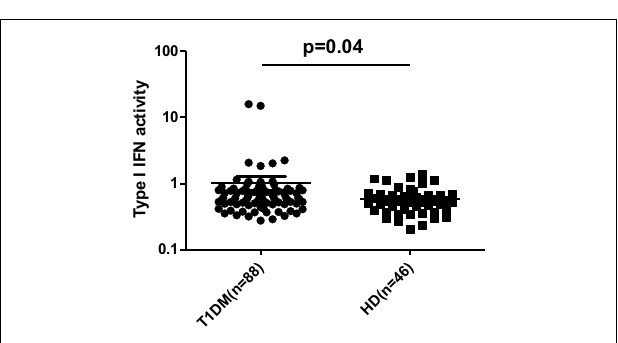
FIGURE 2 | Increased type I IFN activity in patients with type 1 diabetes mellitus (T1DM) ( n = 88) compared to healthy donors (HD) ( n = 46) . Serum type I IFN activity was assessed using a sensitive reporter cell assay as previously described. Symbols represent individual subjects; horizontal lines represent the mean; p -values were calculated by non-parametric Mann–Whitney test.